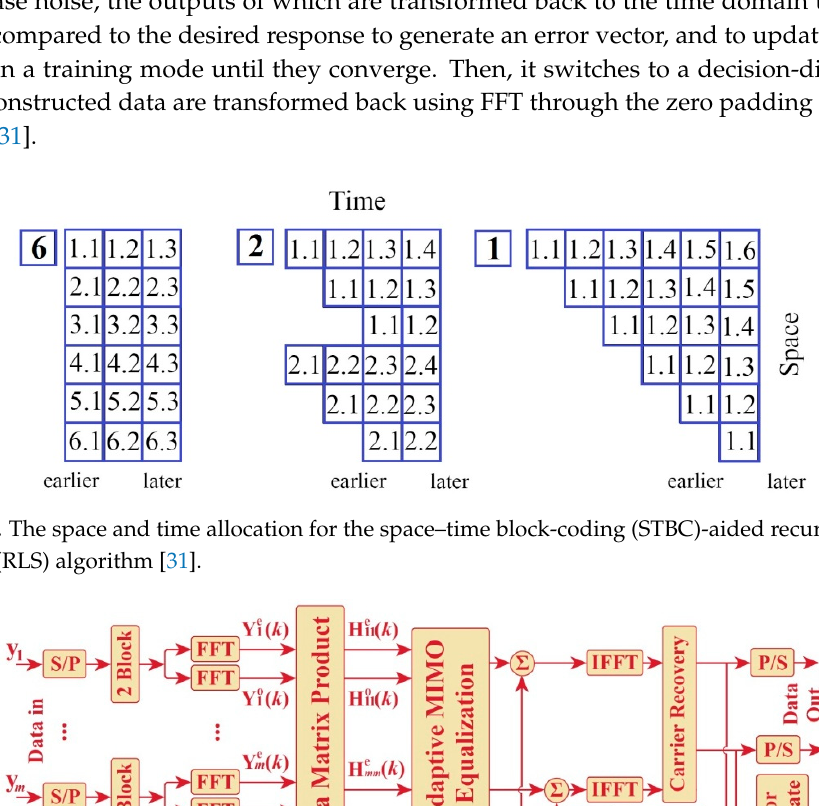
Figure 7. The space and time allocation for the space–time block-coding (STBC)-aided recursive least squares (RLS) algorithm [31].